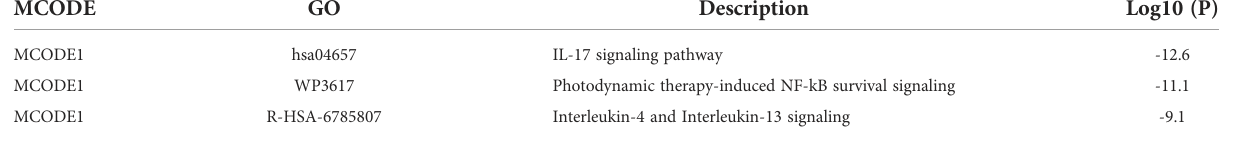
TABLE 1 Gene ontology (GO) enrichment analysis of genes in